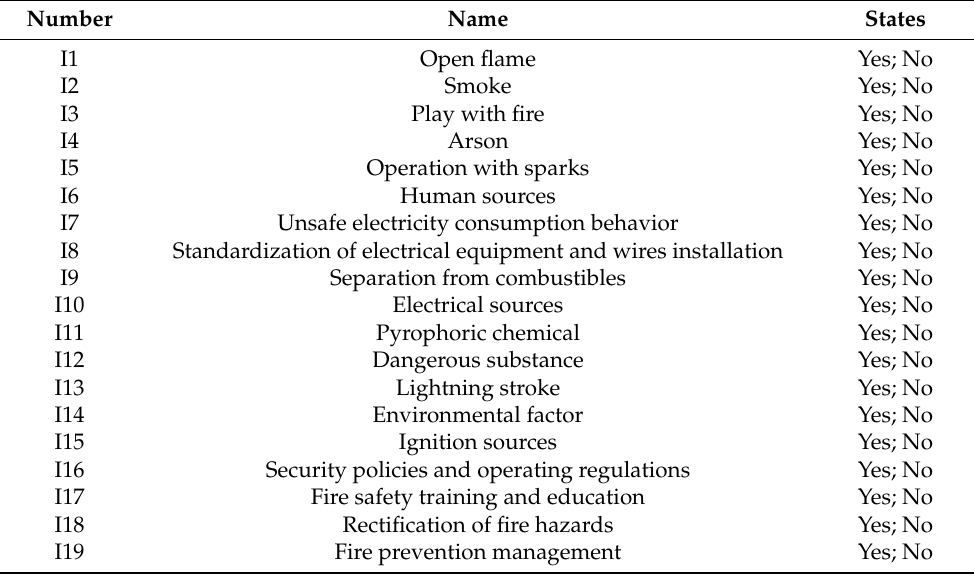
Table A4. The name and states of the nodes related to ignition in Bayesian network.